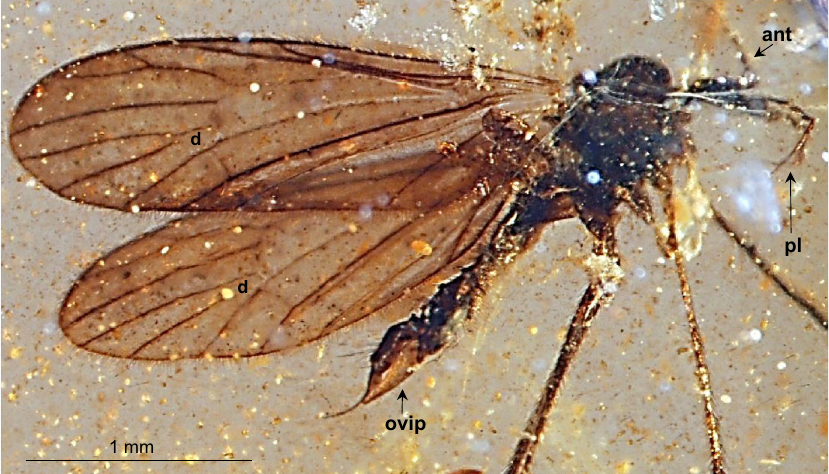
Figure 2. Gonomyia ( Iberiana ) penalveri subgen. et sp. nov. (Limoniidae), inclusions in Spanish amber; body, lateral